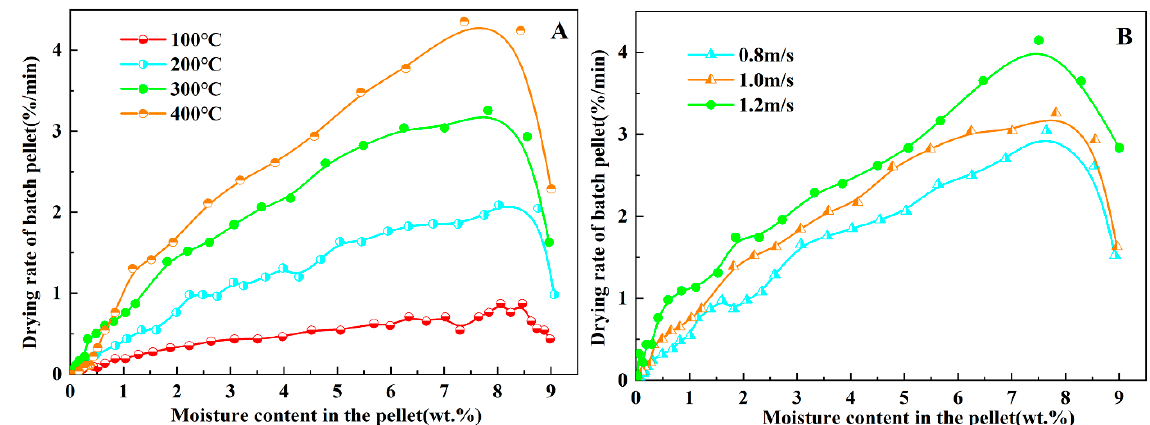
Figure 2. Drying characteristic curve of different wind temperature ( A ) and wind flow rate ( B ) on green pellets containing bentonite.